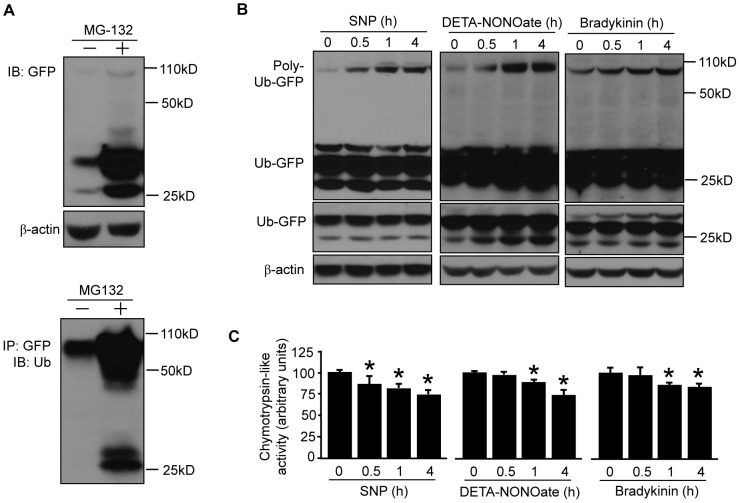
NO donors and Bradykinin increase 26S proteasome reporter protein levels and decrease 26S proteasome activity.The UbG76V-GFP-expressing cells were incubated with (A) MG132 (0.5 µM), or vehicle (DMSO, 0.5%) for 24 h followed by Western blotting of the 26S proteasome reporter protein poly-Ub-GFP by using a rabbit-derived anti-GFP antibody, with or without GFP enrichment by agarose bead conjugated with an anti-GFP antibody. The same type of cells were also incubated with SNP (50 µM), DETA-NONOate (50 µM), or Bradykinin (1 µM) for indicated time up to 4 h. The cell lysate were subjected to (B) Western blotting of reporter proteins with an anti-GFP antibody and to (C) 26S proteasome activity assay by measuring the chymotrypsin-like activity of the cell lysates. The shown blots were representative of at least 3 independent experiments with similar results. * represent p<0.05 vs control (0 h) (n = 3), otherwise, not significant. An overlaid portion (less exposure) of each whole blot in (B) indicating Ub-GFP is presented. DETA-NONOate, Diethylenetriamine NONOate; DMSO, dimethyl sulfoxide; SNP, sodium nitroprusside; Ub-GFP, ubiquitin-green fluorescent protein.